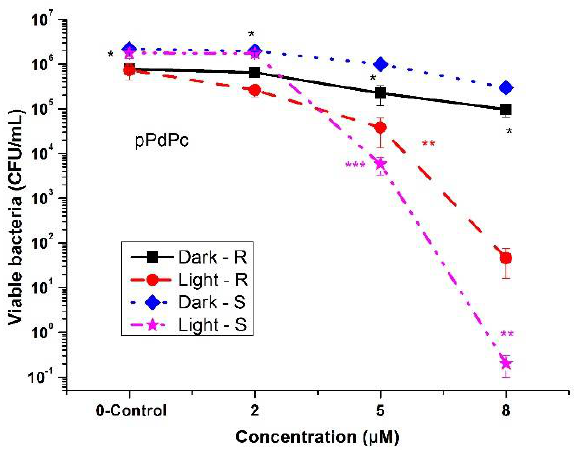
Figure 2. Photodynamic inactivation of A. hydrophila ( R and S ) planktonic cultured with peripheral Pd(II)-phthalocyanine (pPdPc) and an LED at 665 nm irradiation. * p < 0.005; ** p < 0.008, and *** p < 0.01.